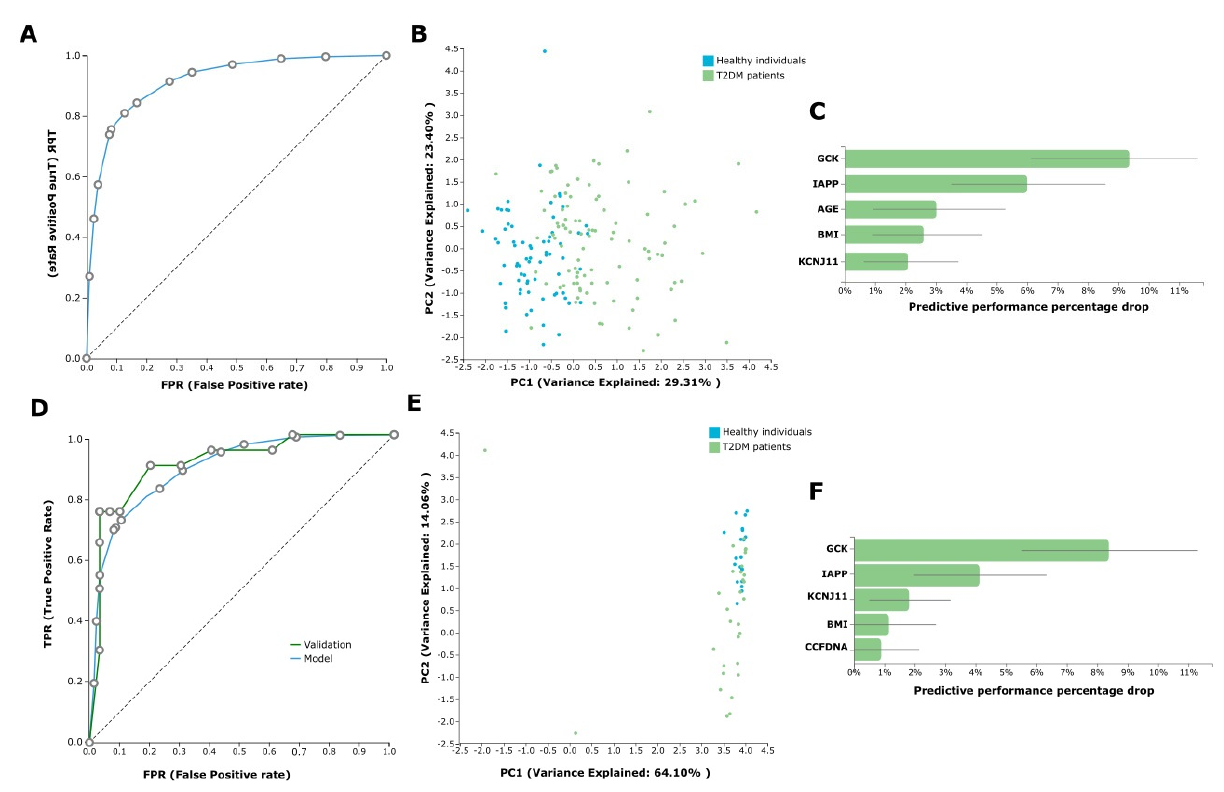
Figure 5. Predictive modelling results. ( A ) ROC curve of whole dataset reaching an AUC of 0.927 (95% CI 0.874–0.967). ( B ) Supervised Principal Component Analysis (PCA) plot of whole dataset depicting discrimination between T2DM patients and healthy individuals. ( C ) Feature importance plot of the features of the best-performing model for the whole dataset. Feature importance is defined as the percentage drop in predictive performance when the feature is removed from the model. ( D ) ROC curve of train sub-dataset (blue line) reaching an AUC of 0.898 (95% CI 0.845–0.944) and test sub-dataset (green line) showing an AUC of 0.923 for the best-performing model. ( E ) PCA plot of test sub-dataset depicting discrimination between T2DM patients and healthy individuals. ( F ) Feature Importance plot of the features of the best-performing model in the train/test 70/30 split sub-datasets. Abbreviations: ROC curve: receiver operating characteristic curve, AUC: area under the curve, CI: confidence interval, T2DM: type 2 diabetes mellitus.